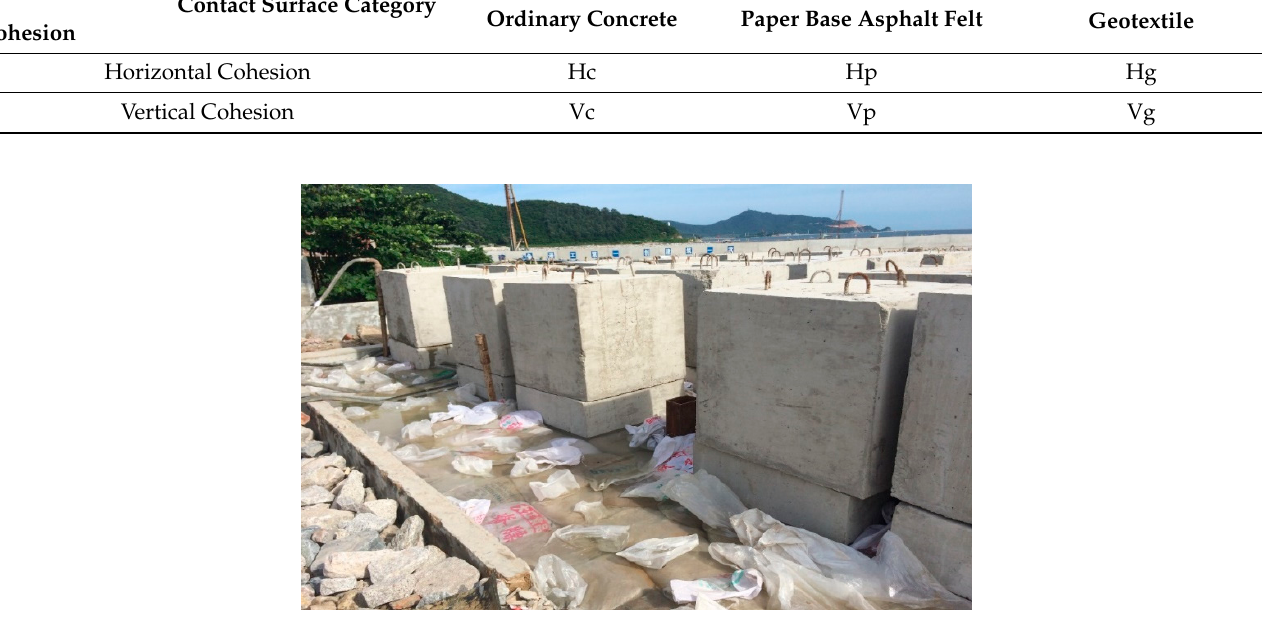
Figure 4. Layout of concrete test blocks.